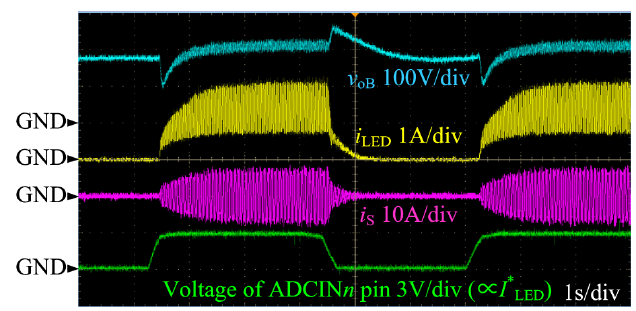
Figure 23. Experimental result when the reference LED current I ∗